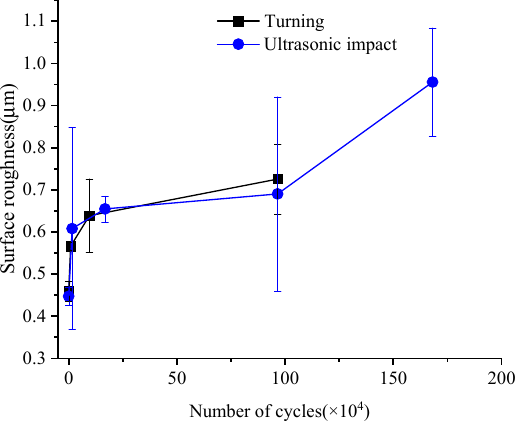
Figure 6. Surface roughness Ra changes during fatigue evolution.